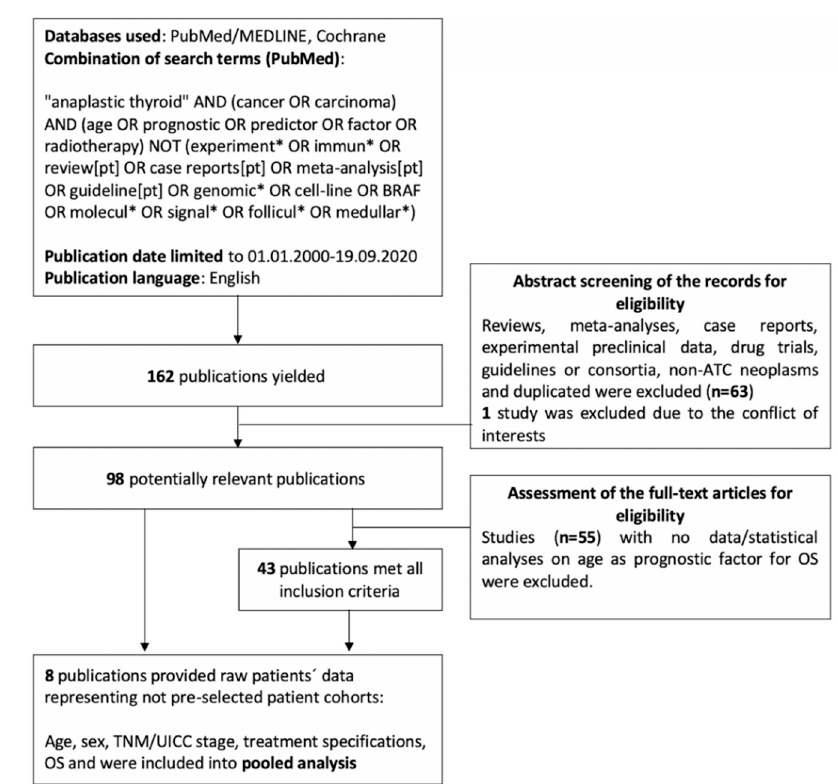
Figure 1. PRISMA flowchart for the systematic review. Table 1. Systematic review of the literature: age as a prognostic factor in patients with anaplastic thyroid cancer (ATC).